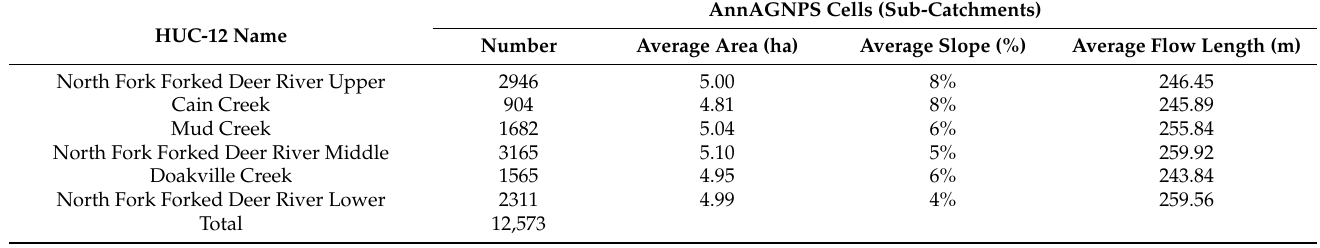
Table 1. Discretization of the watershed into AnnAGNPS cells.